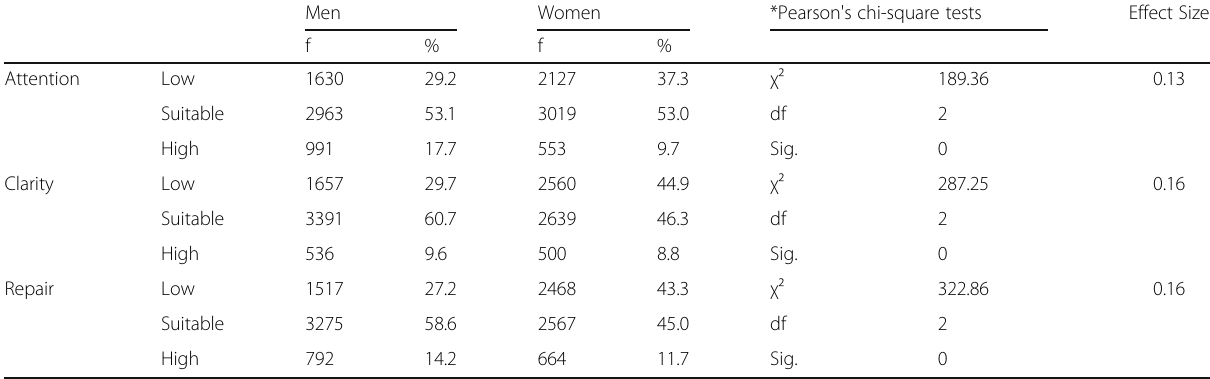
Table 3 Gender proportions in each dimension of Emotional Intelligence Perceived (EIP); Test Chi-Squared and Effect sizes for Cramer ’ s V Men